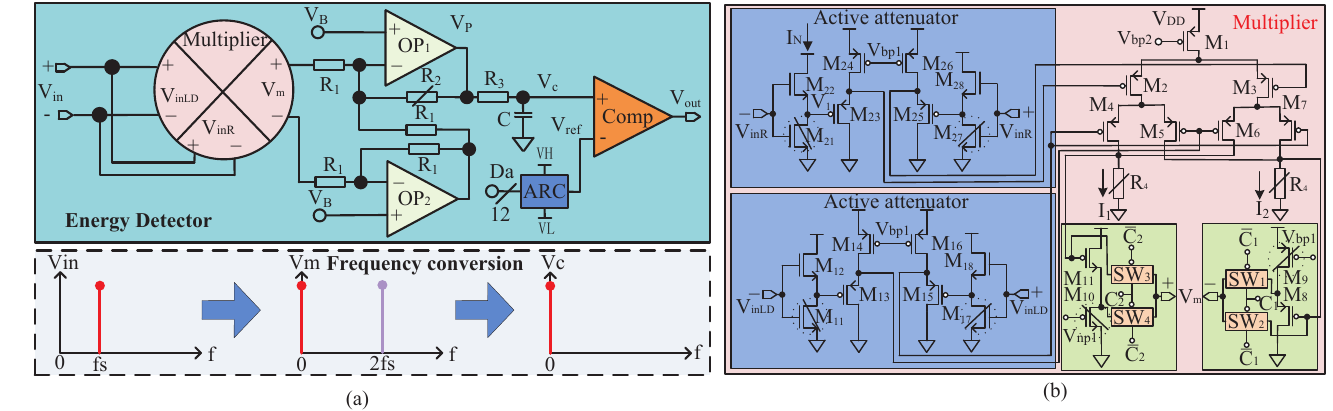
Figure 3. ( a ) Circuit structure of the energy detector, ( b ) circuit of the multiplier.